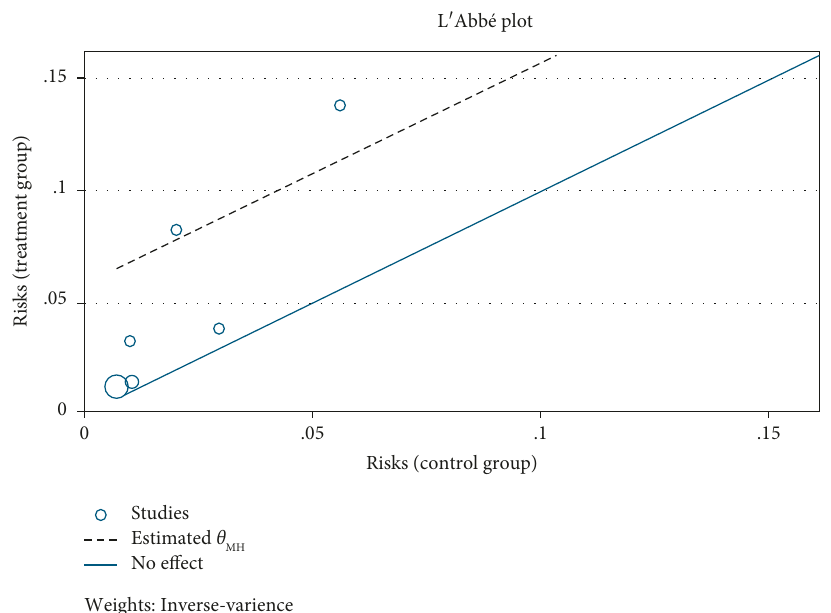
Figure 3: L’Abb´e plot event rate in the case group against the control